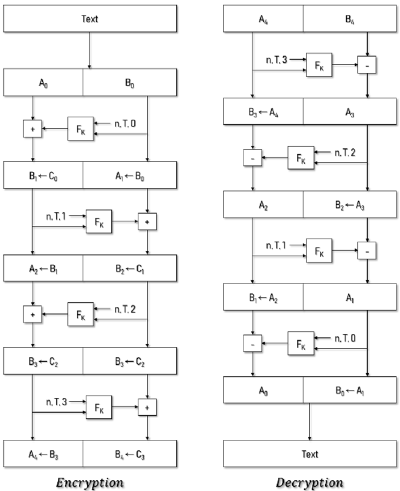
Figure 2. Encryption and decryption structure of format-preserving encryption (FPE) [17].